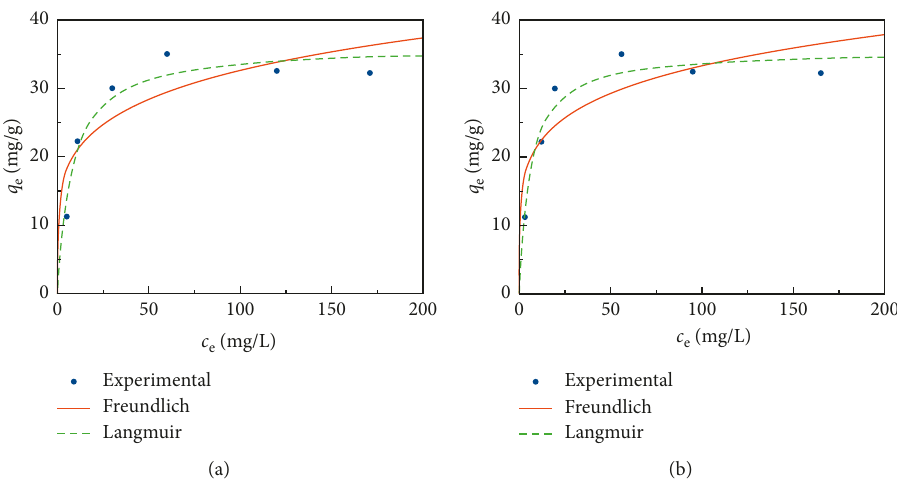
Figure 8: Freundlich and Langmuir nonlinear isotherms of (a) raw sawdust and (b) chemically treated sawdust for chrysoidine removal.